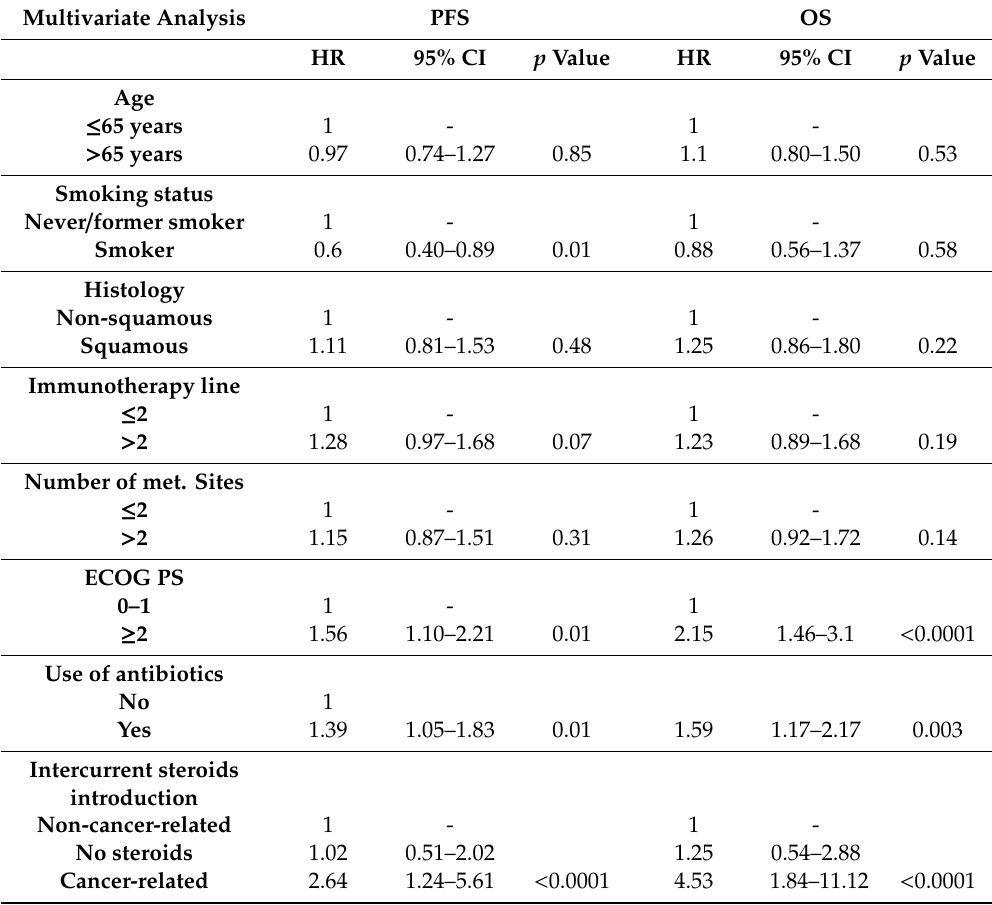
Table 2. Multivariate analysis for PFS and